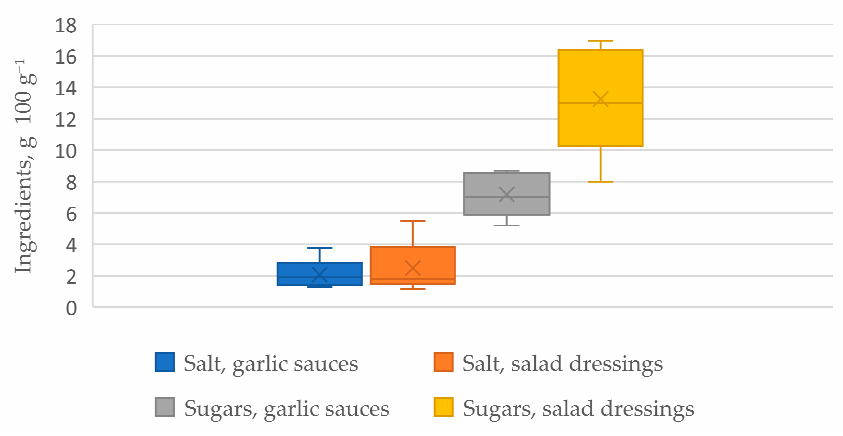
Figure 1. Average salt and sugar content in commercially available salad dressings and garlic sauces.